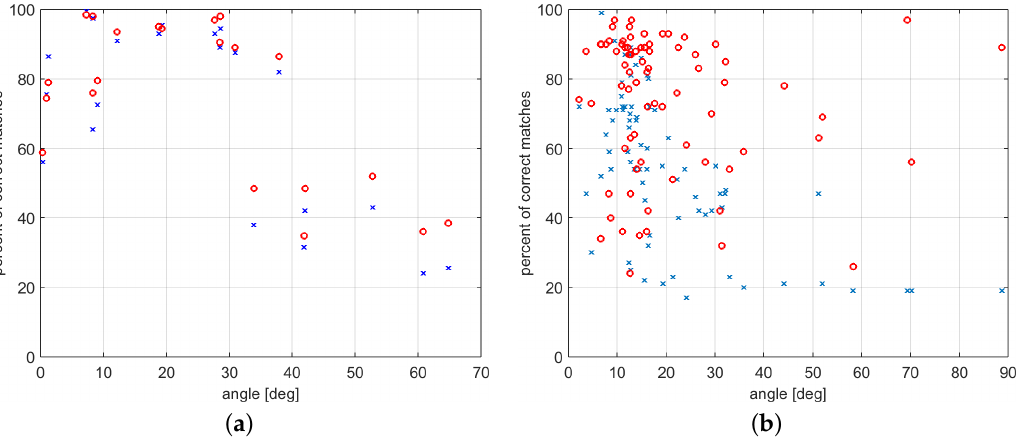
Figure 7. Percent of correctly matched features varying the angle between the camera poses. Comparison of number of matched features with standard SIFT ( blue crosses), and with the method proposed in Section 2 ( red circles) in the second ( a ), and third ( b ) case study,